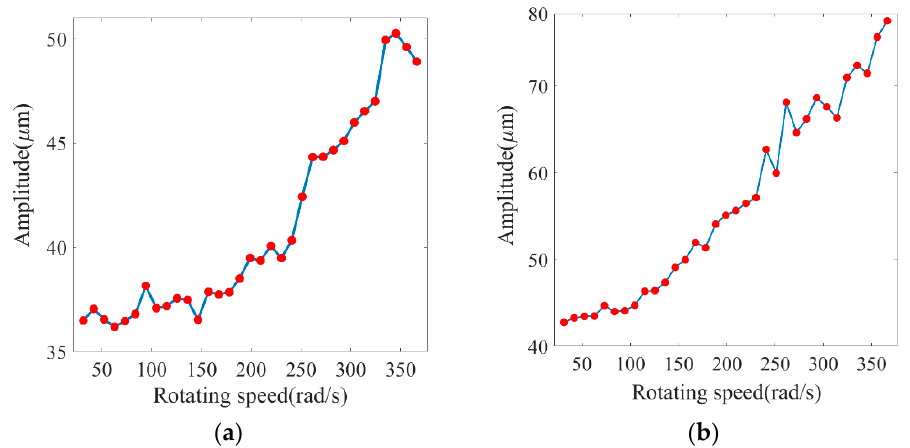
Figure 6. Variation diagram of system amplitude under different oil pressure. ( a ) Oil pressure level of 0.2 MPa. ( b ) Oil pressure level of 1.0 MPa.